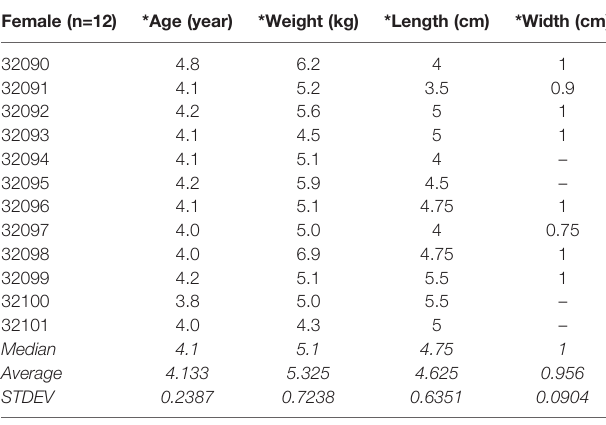
TABLE 2 | Female macaques: age, weight, vaginal length and